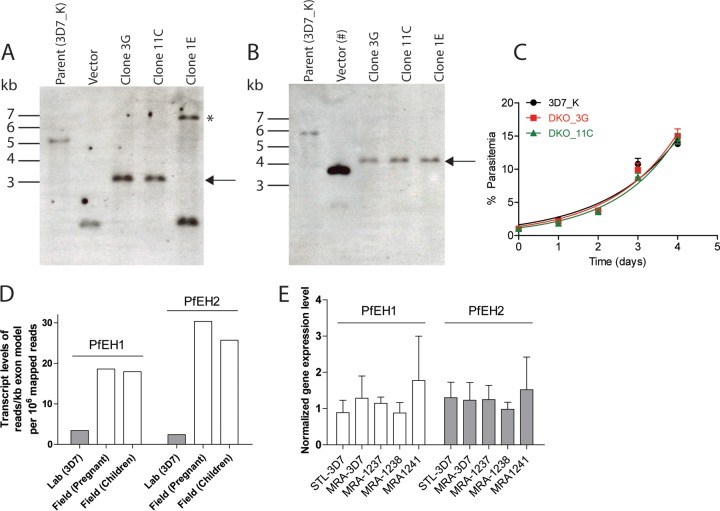
PfEH1 and PfEH2 can be knocked out in cultured parasites. (A and B) Southern blots of digested genomic DNA from the parent 3D7 line, vector, and double-knockout clones. Analysis at both the PfEH1 (A) and PfEH2 (B) loci demonstrate the simultaneous disruption of both genes in clones 3G and 11C, but not in clone 1E. The black arrows to the right of the blots indicate the expected size for correct integration, and the asterisk indicates a band of unknown origin. In panel B, the pUF-TK_PfEH2 vector [Vector (#)] was used instead of pCC1_PfEH2 (called pABH-DKO in reference 89). The schematic representations of the integration events are outlined in Fig. S2 in the supplemental material. (C) Growth of the 3D7 parent line and the two double-knockout (DKO) clones over 4 days. No differences were observed in growth between these three cell lines, with this graph representative of data from three independent experiments. The doubling times are 1.14 ± 0.12 days for the 3D7 parent, 1.16 ± 0.10 days for double-knockout clone 3G, and 1.26 ± 0.12 days for double-knockout clone 11C (not significantly different [P > 0.53] using pairwise t tests; n = 3 for each). The smooth curve is the fitted exponential growth equation. (D) Transcript levels of PfEH1 and PfEH2 in unsynchronized 3D7 laboratory strain compared to field isolates from malaria-infected pregnant women or malaria-infected children. The data shown were taken from Vignali et al. (48). (E) Normalized expression of PfEH1 or PfEH2 in two laboratory strains (Saint Louis STL-3D7 or MRA-3D7) and three laboratory-adapted field isolates from Cambodia (MRA-1237, MRA-1238, and MRA-1241). Quantitative RT-PCR was performed using probes against PfEH1 and PfEH2, with actin as a reference gene. Values are normalized to the average expression in STL-3D7 and MRA-3D7. Data were calculated from three independent RNA preparations (means plus SEMs [error bars]) and are not significantly different using a two-way ANOVA (P > 0.05).